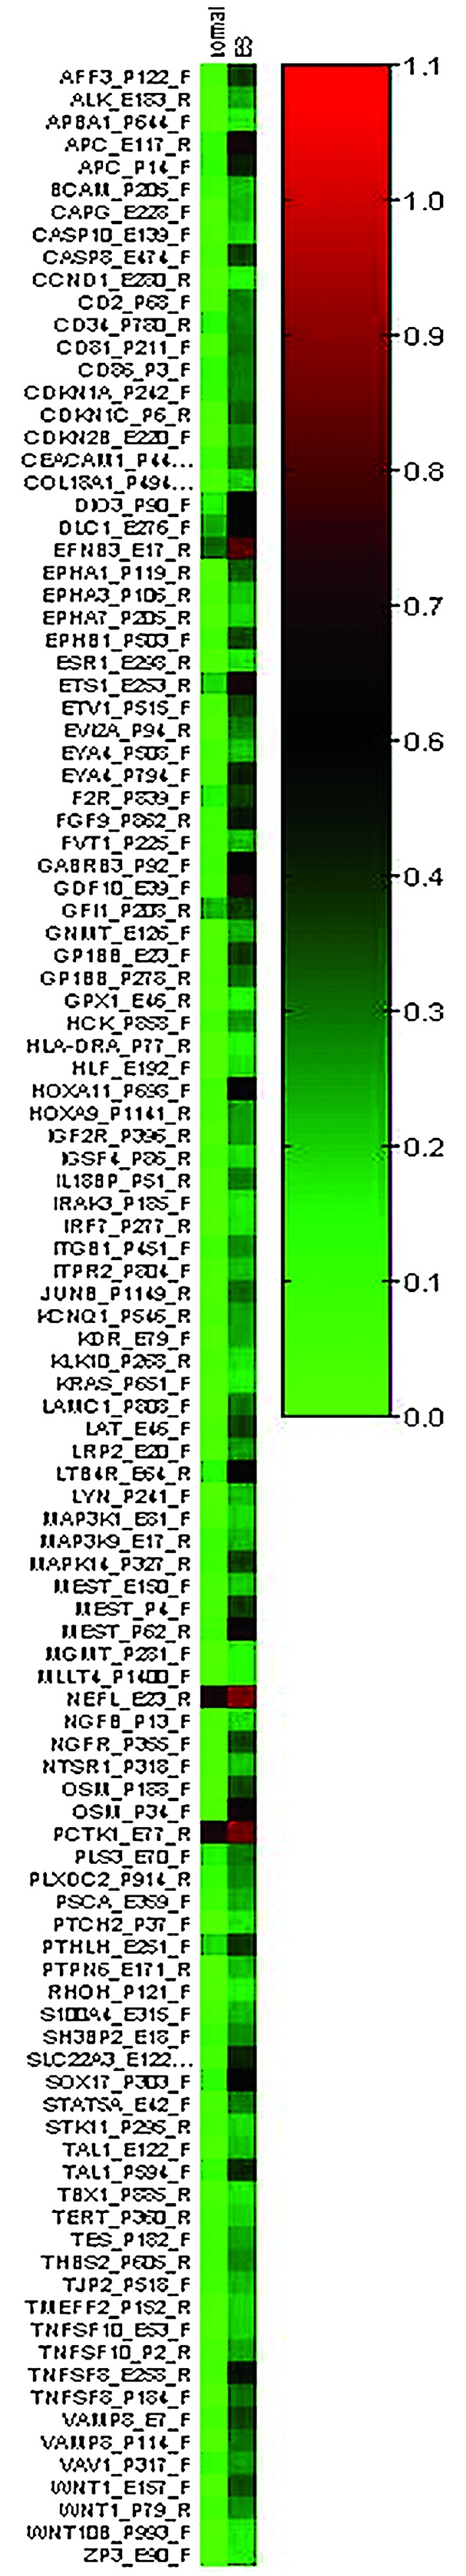
Heat map showing the differentially-methylated CpGs in the Ewing’s sarcoma samples. Red, methylated genes; green, unmethylated genes.